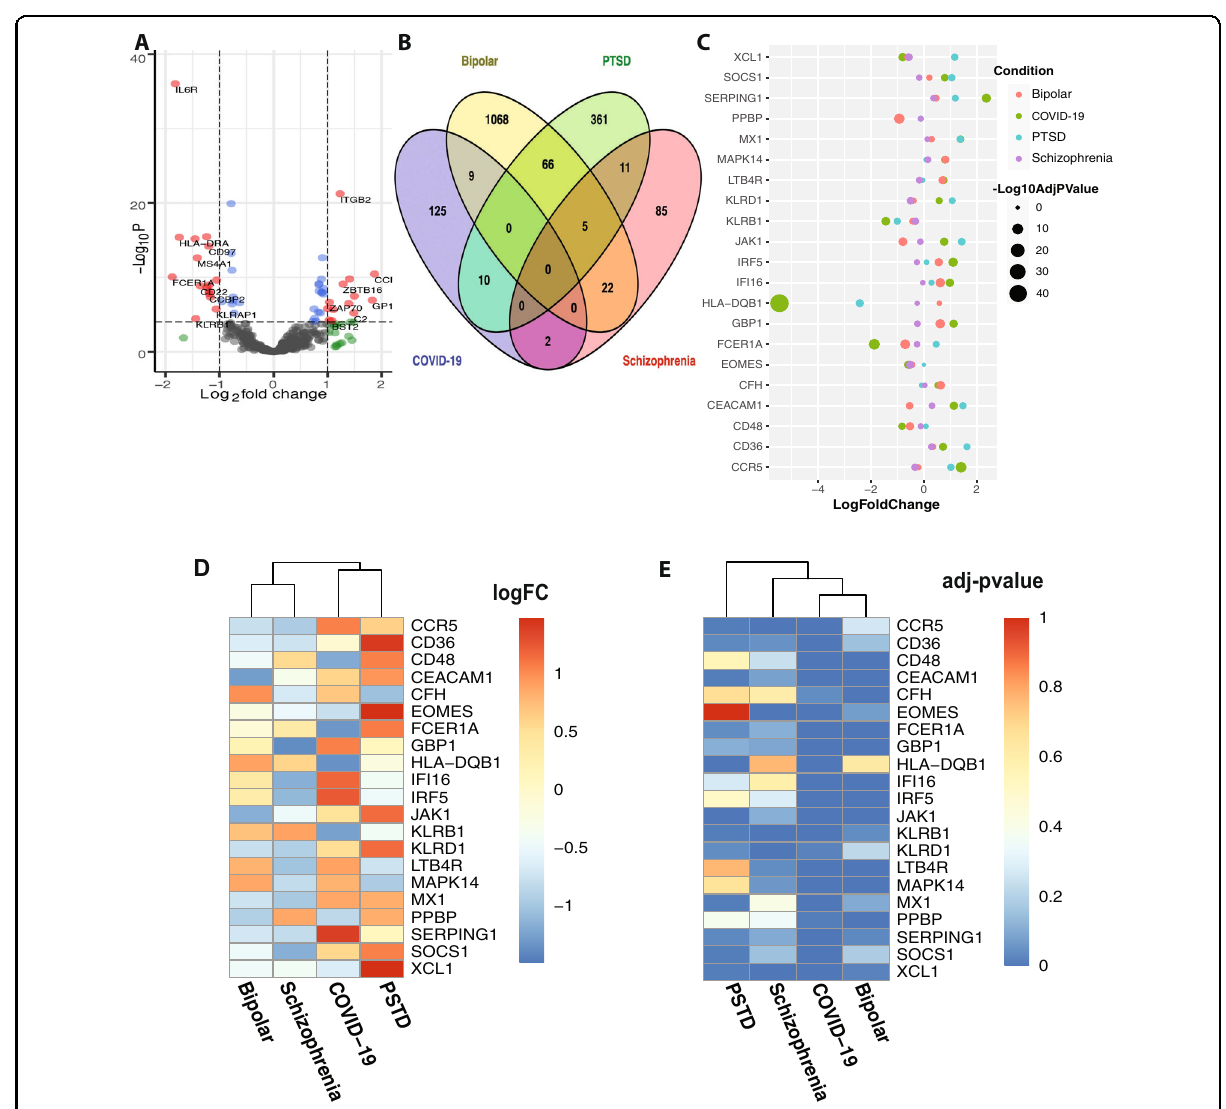
Fig. 3 Targeted immune pro fi ling of SARS Cov-2 infected patient blood using a Nanostring targeted immunology reveals systemic immune responses genes to infection, and shared common genes with the Bipolar disorder, PTSD and Schizophrenia. A Volcano plot of the Nanostring RNA-seq SARS-CoV-2 data shows genes with their threshold log fold changes and adjusted p -values to consider as signi fi cant genes. B Venn diagram shows the number of common signi fi cant genes of SARS Cov-2 in the immune panel with the bipolar disorder, PTSD and schizophrenia PBMC transcriptomic genes. C Bubble plot shows the combined log fold changes and adjusted p -values for the shared common genes between SARS-CoV-2 in the immune panel and either of the bipolar disorder, PTSD and schizophrenia PBMC transcriptomic genes. D Heat map of the log fold changes for the shared common genes between SARS-CoV-2 in the immune panel and either of the bipolar disorder, PTSD and schizophrenia. E Heat map of the adjusted p -values for the shared common genes between SARS-CoV-2 in the immune panel and either of the bipolar disorder, PTSD and schizophrenia, respectively, based on the PBMC transcriptomic